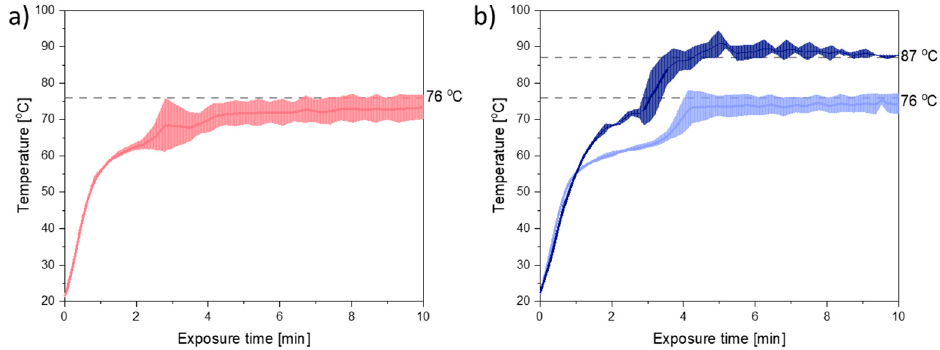
Figure 2. Temperature plots obtained during exposure to microwave radiation for ( a ) PEG 3000 compacts during 10 min of exposure at the target temperature of 76 °C (light red); ( b ) PEG 4000 compacts during 10 min of exposure at the target temperature of 76 °C (light blue) and 87 °C (dark blue). Mean (interpolated) ± SD ( n = 3).